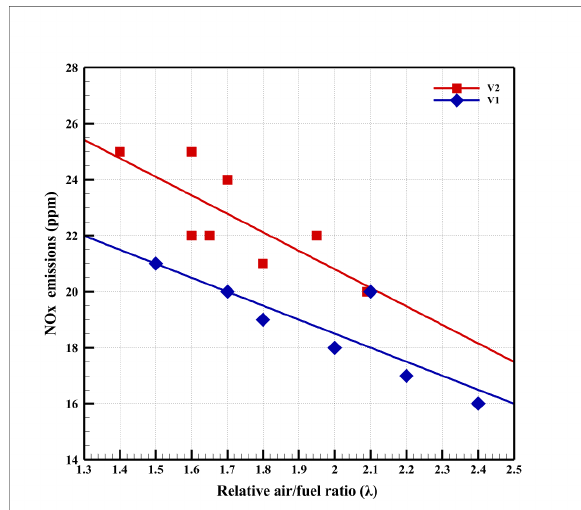
Fig. 11. Variation of NO x concentration with equivalence ratio for two different pulse combustor volume residence time at high temperatures, which in turn reduces the amount of NO x generated in V1. The obtained results are consistent with pervious findings